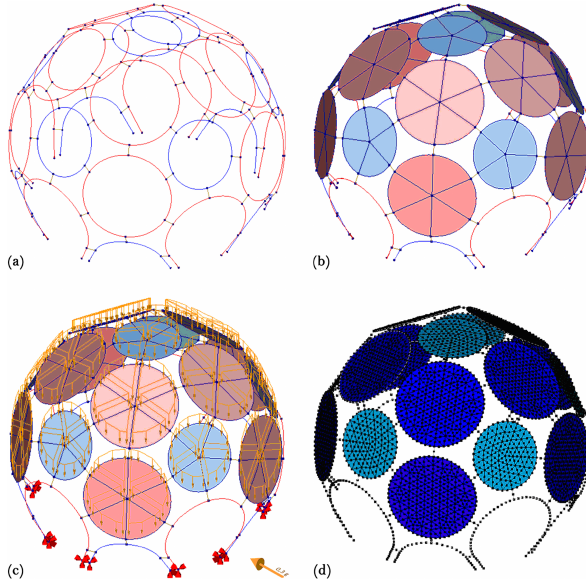
horizontal acceleration equal 0.3 g, where g is the gravity acceleration. Figure 14: Diana FEA setting phases: (a) Model with all the direc- tions of the structural elements is presented: in red, the hexagon’s beams; in blue, pentagonal beams; in black, the junctions; (b) in- sertion of the infilling surfaces; (c) Complete DIANA model with the application of the snow load and the seismic actions; (d) Output of the calculus obtained by the software